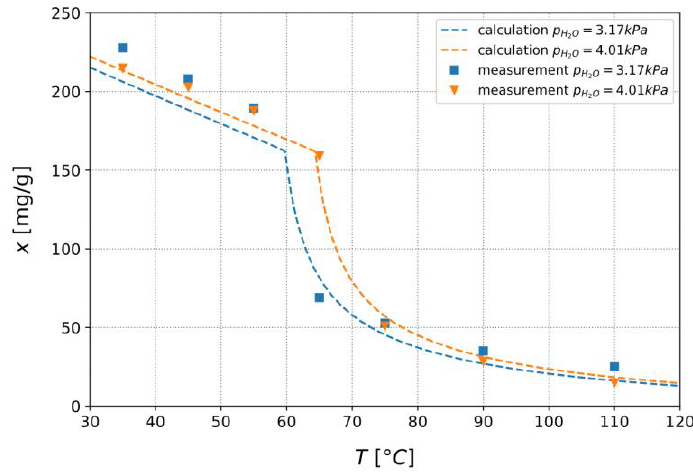
Figure 12. Calculated adsorption isobars in comparison to measured adsorption isobars at adsorptive water vapor pressures of 3.17 and 4.01 kPa, which corresponds to a condenser temperature of the heat pipe of 25 and 29 °C, respectively.